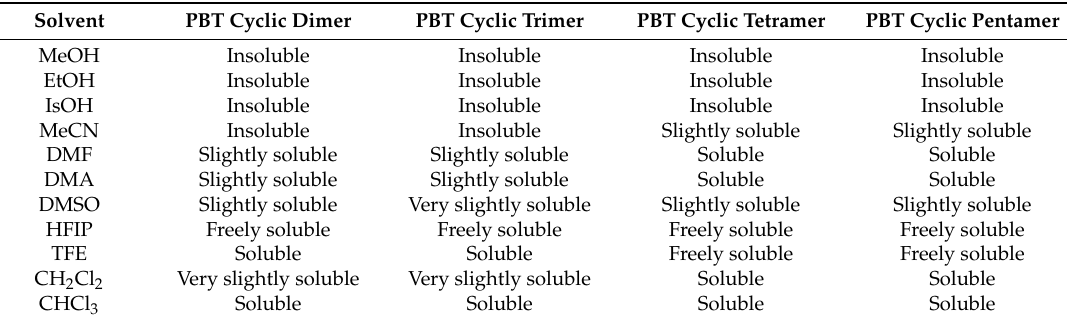
Table 1. Results of solubility studies for all four isolated PBT cyclic oligomers, from dimer to pentamer, according to WHO/FAO